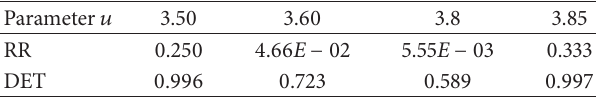
Table1:RRandDETcorrespondingtoseriesoflogisticmodelswith different